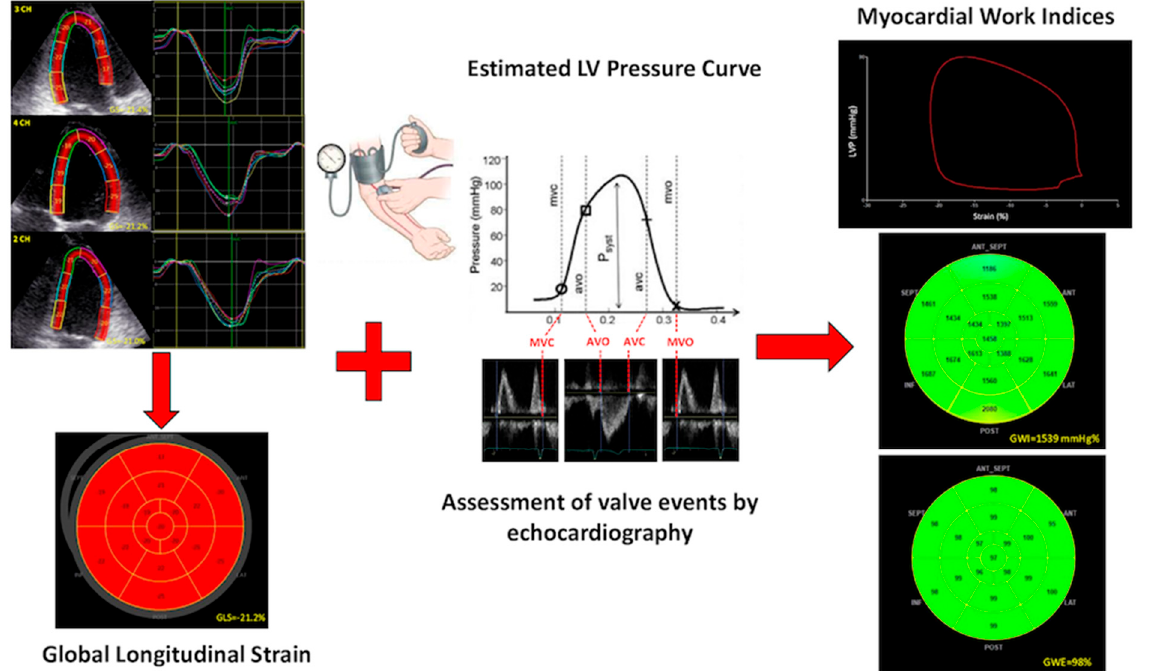
Figure 1. LV global longitudinal strain data, measured using the R-wave onset in the electrocardiogram as a common time reference (left panel), are combined with estimated LV pressure curve. After measuring peak arterial pressure with a cuff manometer, an empiric, normalized reference curve is adjusted according to LV duration of the isovolumetric and ejection phases, defined by timing of aortic and mitral valve events by echocardiography (central panel). On the right panel, representative trace showing LV pressure-strain loop (up), 17-segment bull’s-eye representation of MW index (middle) and MW efficiency (bottom). AVC = aortic valve closure; AVO = aortic valve opening; GWI = global work index; GWE = global work efficiency; LV = left ventricular; LVP = left ventricular pressure; MVC = mitral valve closure; MWO = mitral valve opening.